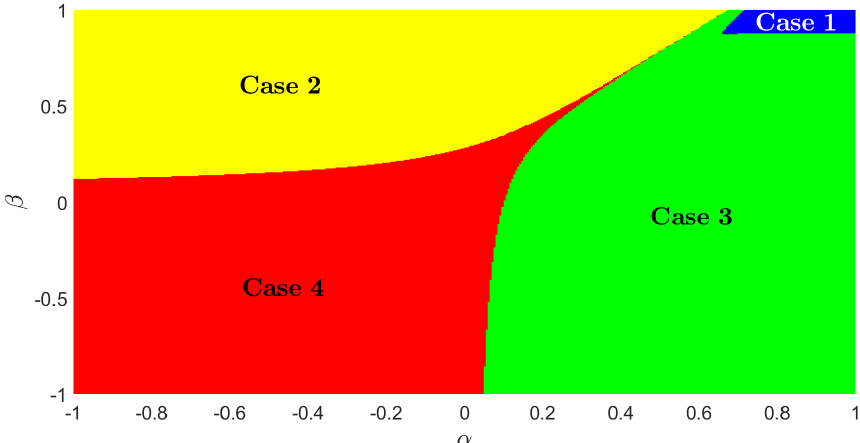
Figure 4. Two-dimensional bifurcation diagram varying α and β . Every color represents the system behavior for each case previously